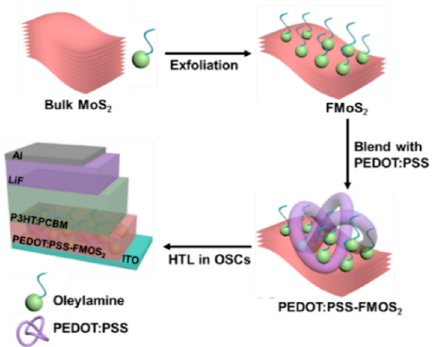
Figure 1. Fabrication process for poly(3,4-ethylenedioxythiophene):poly(styrenesulfonate) (PEDOT:PSS)/oleylamine-functionalized MoS 2 (FMoS 2 ) hybrid hole-transporting layer (HTL) for organic solar cells.